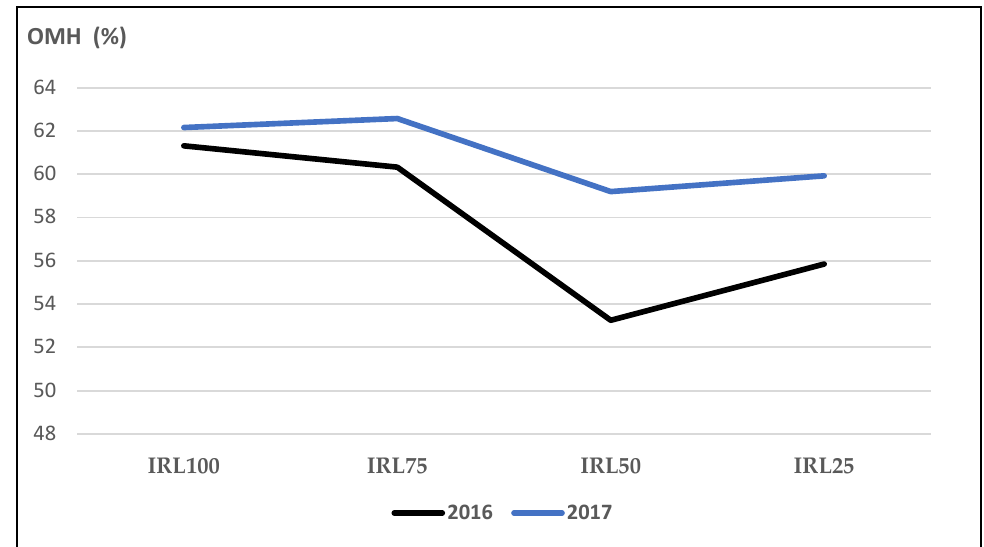
Figure 3. Mean values of OMH (%) at different IRLs of O. basilicum L. essential oil; IRL 100 = 100% FC; OMH: oxygenated monoterpene hydrocarbons, IRL 75 = 75% FC; IRL 50 = 50% FC; IRL 25 = 25% FC without SM.